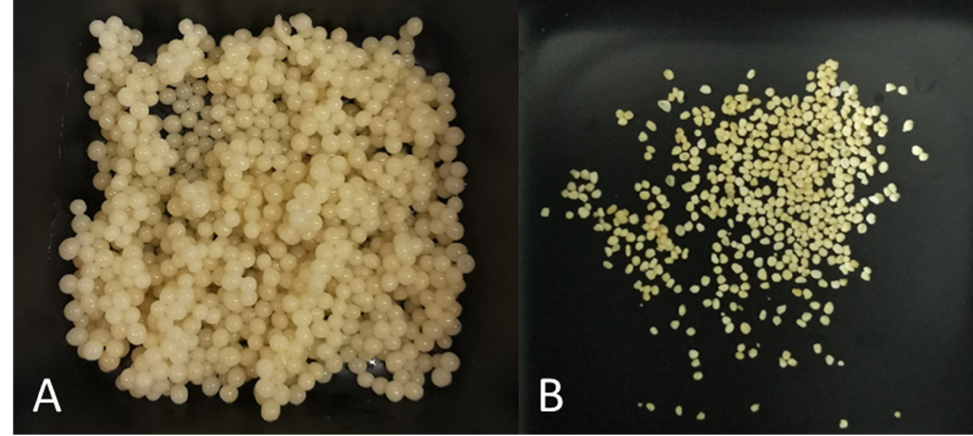
Figure 3. Extruded microcapsules ( A ) immediately after extrusion and ( B ) after drying the micro-